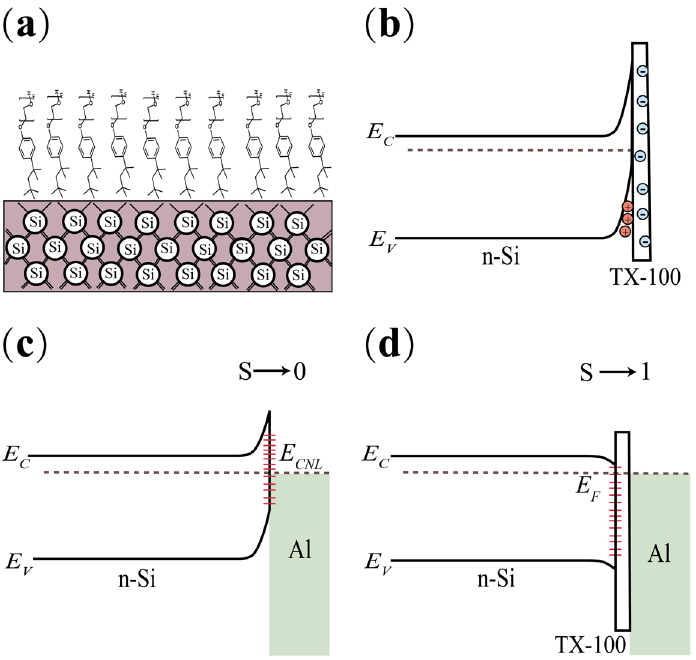
Figure 3. ( a ) Schematic diagram of organic molecules regularly arranged on the c-Si surface and ( b ) the resulted energy band bending for c-Si; ( c ) M-S contact, where the Fermi level of the system is pinned to a constant energy level E CNL ; ( d ) the interfacial Fermi level pinning (FLP) effect mitigating by TX-100.